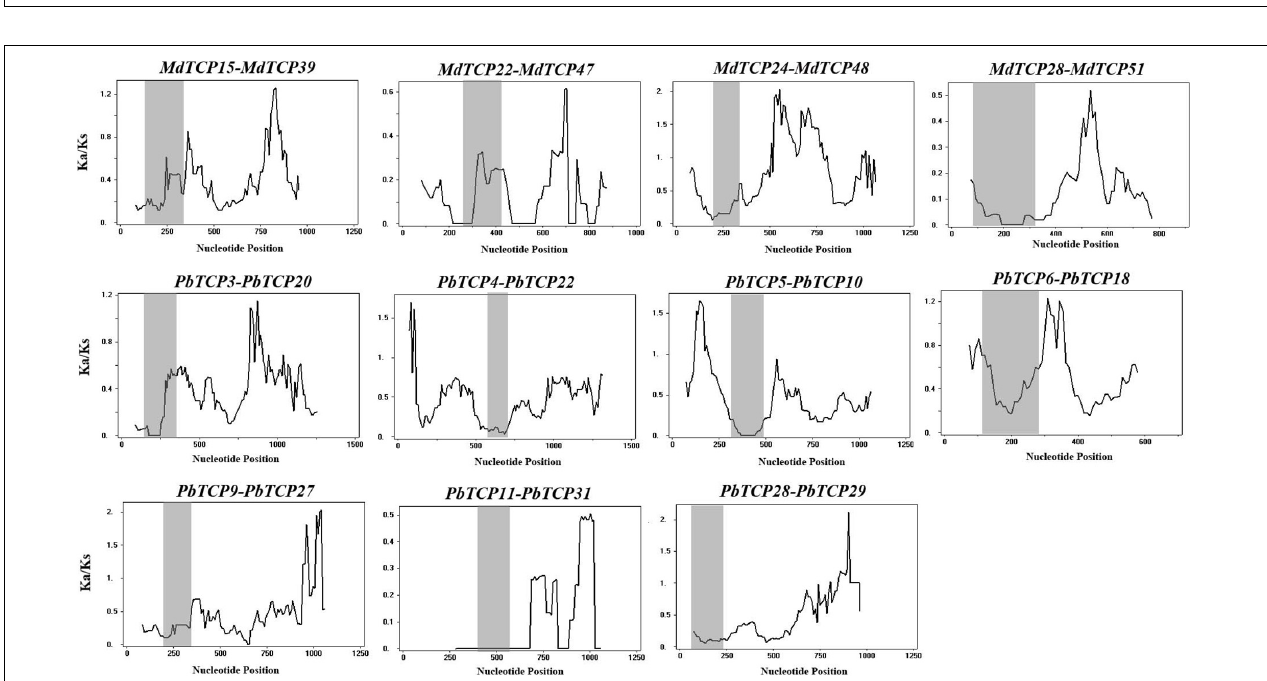
FIGURE 4 | Sliding window plots of duplicated TCP genes in Pyrus bretschneideri and Malus domestica. The gray shaded portion indicates conserved TCP domain. The X -axis indicates the synonymous distance within each gene.